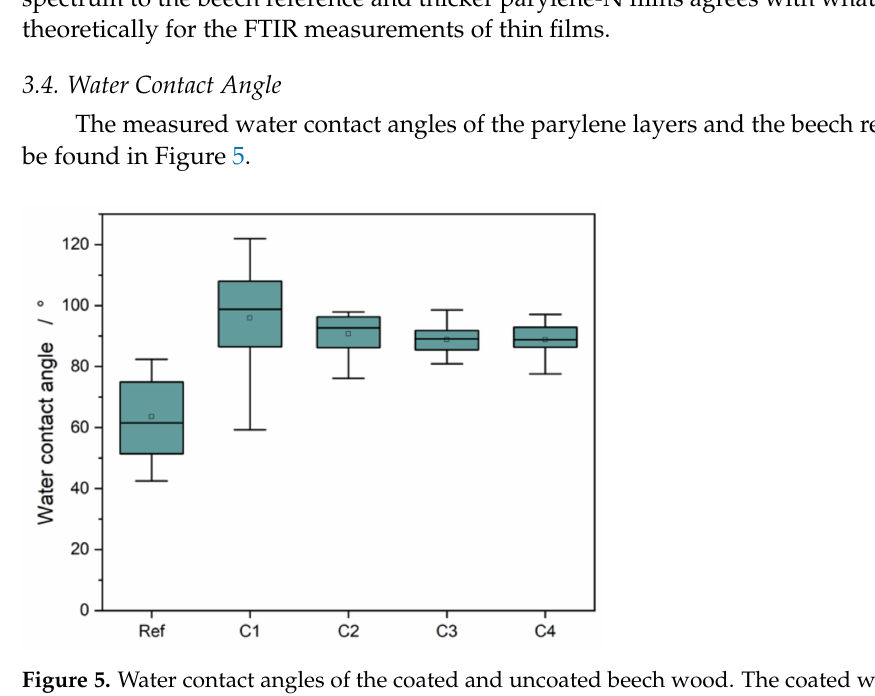
Figure 5. Water contact angles of the coated and uncoated beech wood. The coated wood surfaces showed an increase of the contact angle by 25–32 ◦